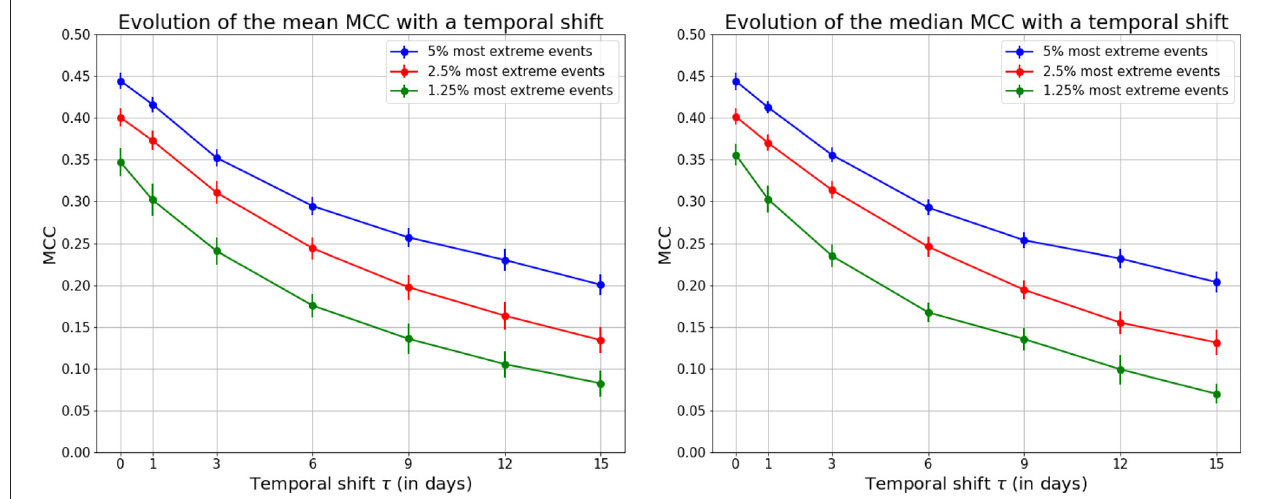
FIGURE 4 | Heatwave occurrence prediction performance in MCC as function of the number of days in advance τ . Mean MCC, with standard deviation, (left plot) and median MCC, with max absolute deviation, (right plot), obtained as averages across the 40 independent learning, for the three levels of extreme events. These plots clearly show that achieved MCC are significantly above 0 indicating the ability of the proposed Deep Learning procedure to predict heatwave extreme events τ days in advances from the sole observations of the surface temperature and geopotential height fields at a single date.